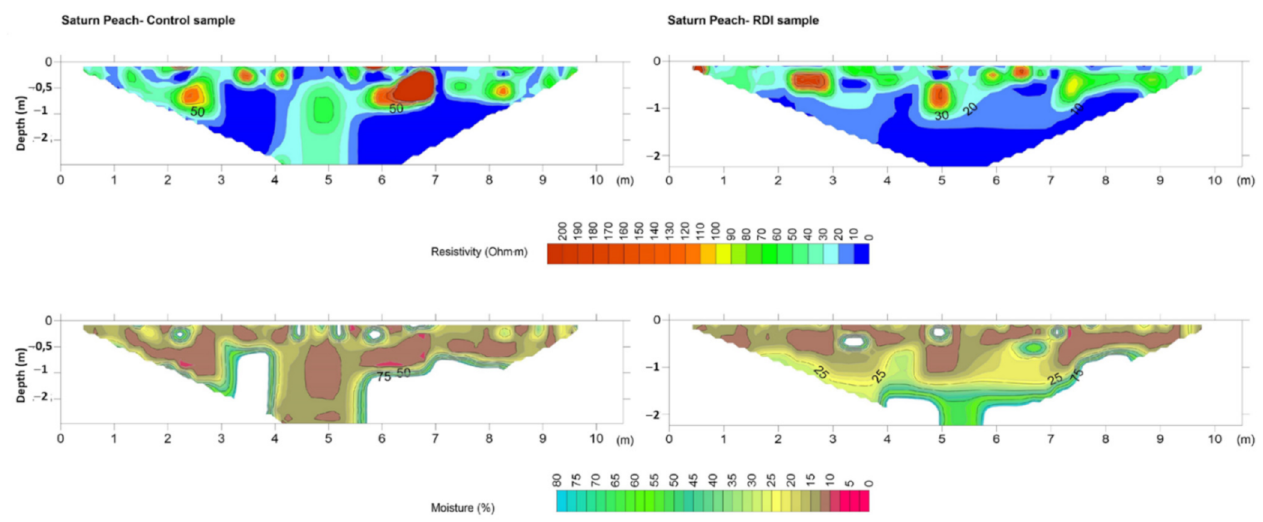
Figure 8. Resistivity model ( top ) and predicted soil moisture ( bottom ) for control ( left ) and deficit irrigation ( right ) in the Saturn peach